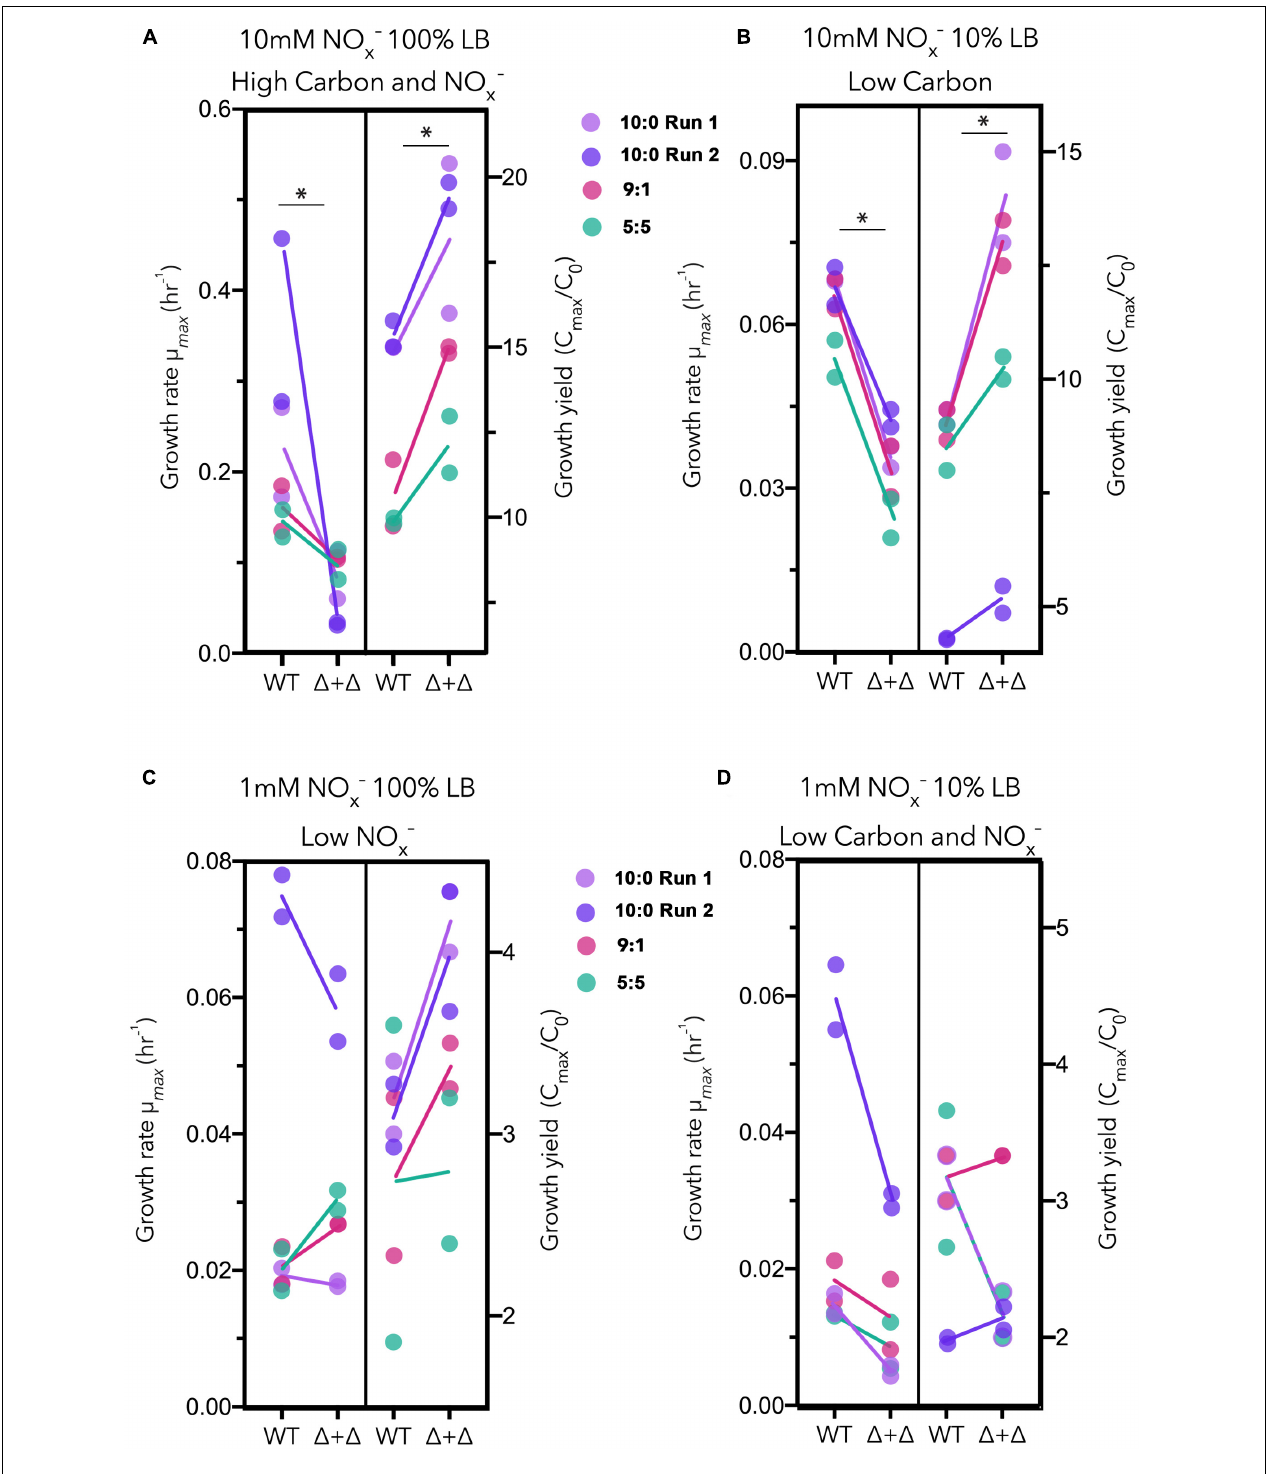
FIGURE 3 | Growth rate vs. growth yield for generalists and specialists in LB. Results for three stoichiometric NO 3 − /NO 2 − ratios (10:0 run 1, lavender; 10:0 run 2, dark purple; 9:1, red; 5:5, green) are plotted together for each nutrient regime as follows: (A) high carbon and NO x − , (B) low carbon, (C) low NO x − , and (D) low carbon and NO x − . Maximum growth rates ( µ max ) vs. growth yields (C max /C 0 ) are plotted separately for wild-type (WT) and (cid:49) nar + (cid:49) nir co-culture ( (cid:49) + (cid:49) ). For both WT and (cid:49) + (cid:49) , n = 4 for the 10:0 NO 3 − /NO 2 − ratio and n = 2 for the 9:1 and 5:5 ratio for each nutrient regime, and n = 8 for each nutrient regime including all depicted ratios, omitting